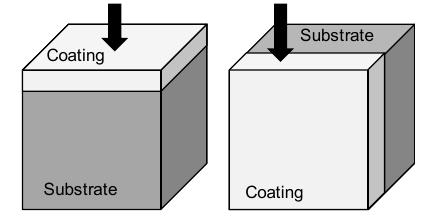
Fig. 2 Schematic of the cross-sectional measurement (a) and the measurement normal to the coating surface (b).